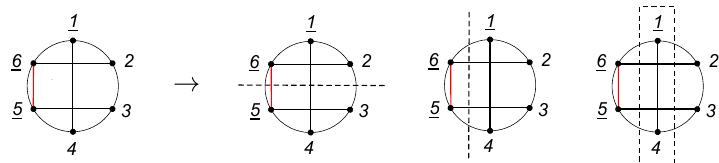
Figure 22 . Another Pfaffian choice for A ( I 6 :14 , 26 , 35) and its factorization contributions.